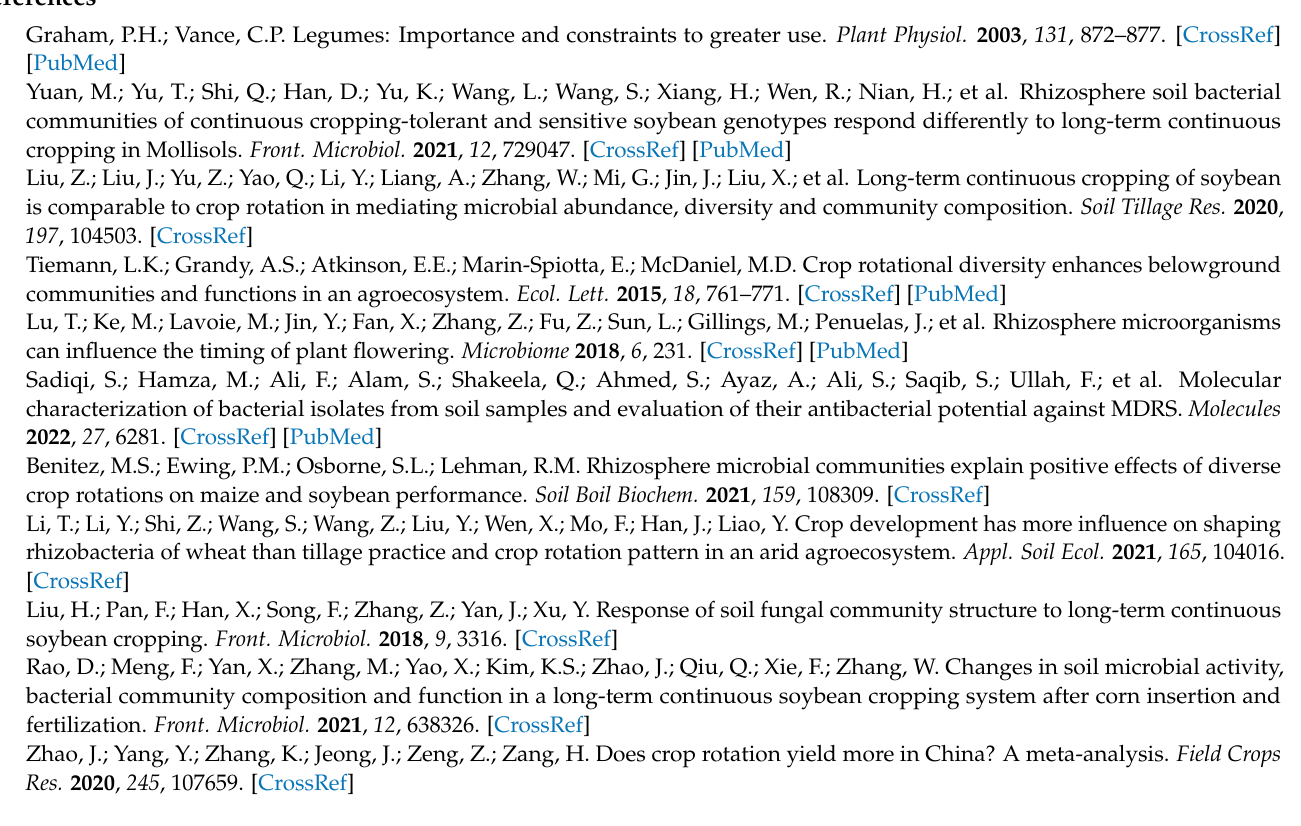
Table S1: Relative abundances of the fungal phyla and genera in the rhizosphere soils under con- tinuous wheat/soybean cropping system (W/S) and wheat/soybean-wheat/maize rotation system (W/S-W/M); Table S2: Relative abundances of the bacterial phyla and genera in the rhizosphere soils under continuous wheat/soybean cropping system (W/S) and wheat/soybean-wheat/maize rotation system